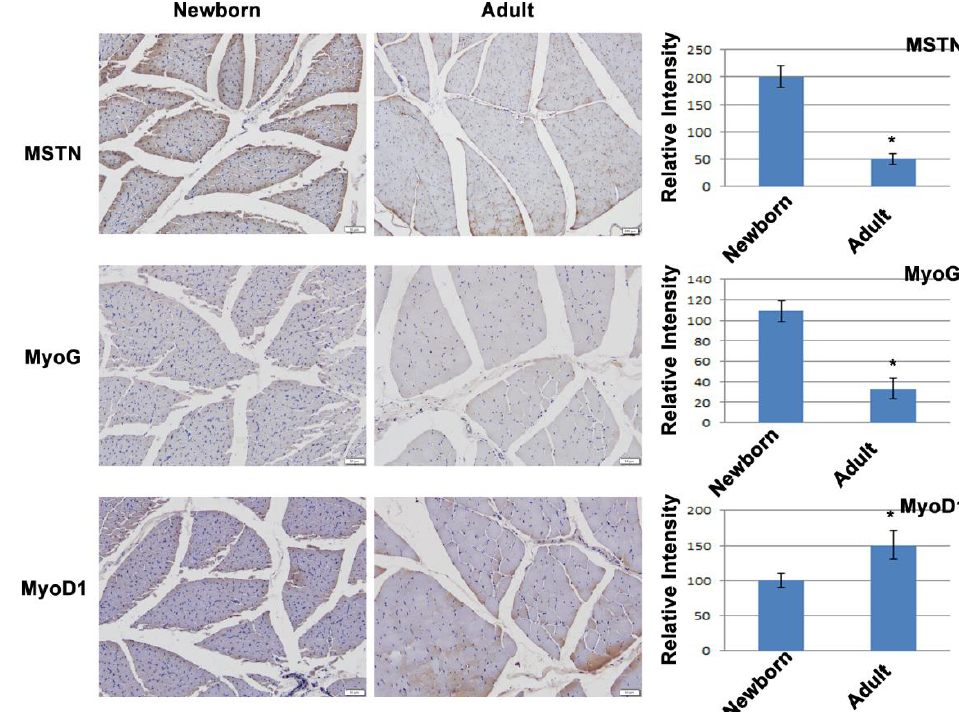
Figure 4. Immunohistochemistry staining of MSTN , MyoG , and MyoD1 expression in newborn and adult equine muscles. The positive signals are quantified in left bar charts. * Indicates the significance at the level of p < 0.05.